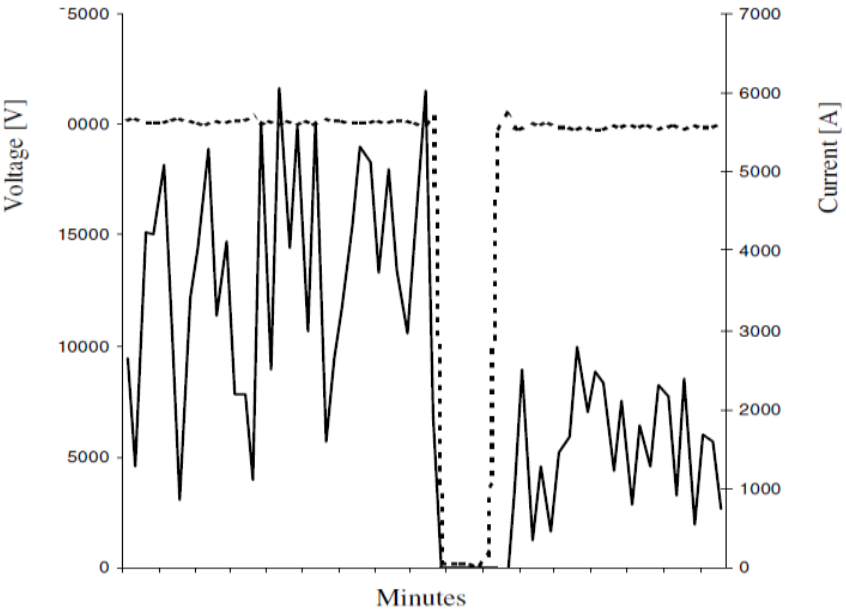
Figure 19. The measured sustained interruption with 3.5 min duration in Rome metro line